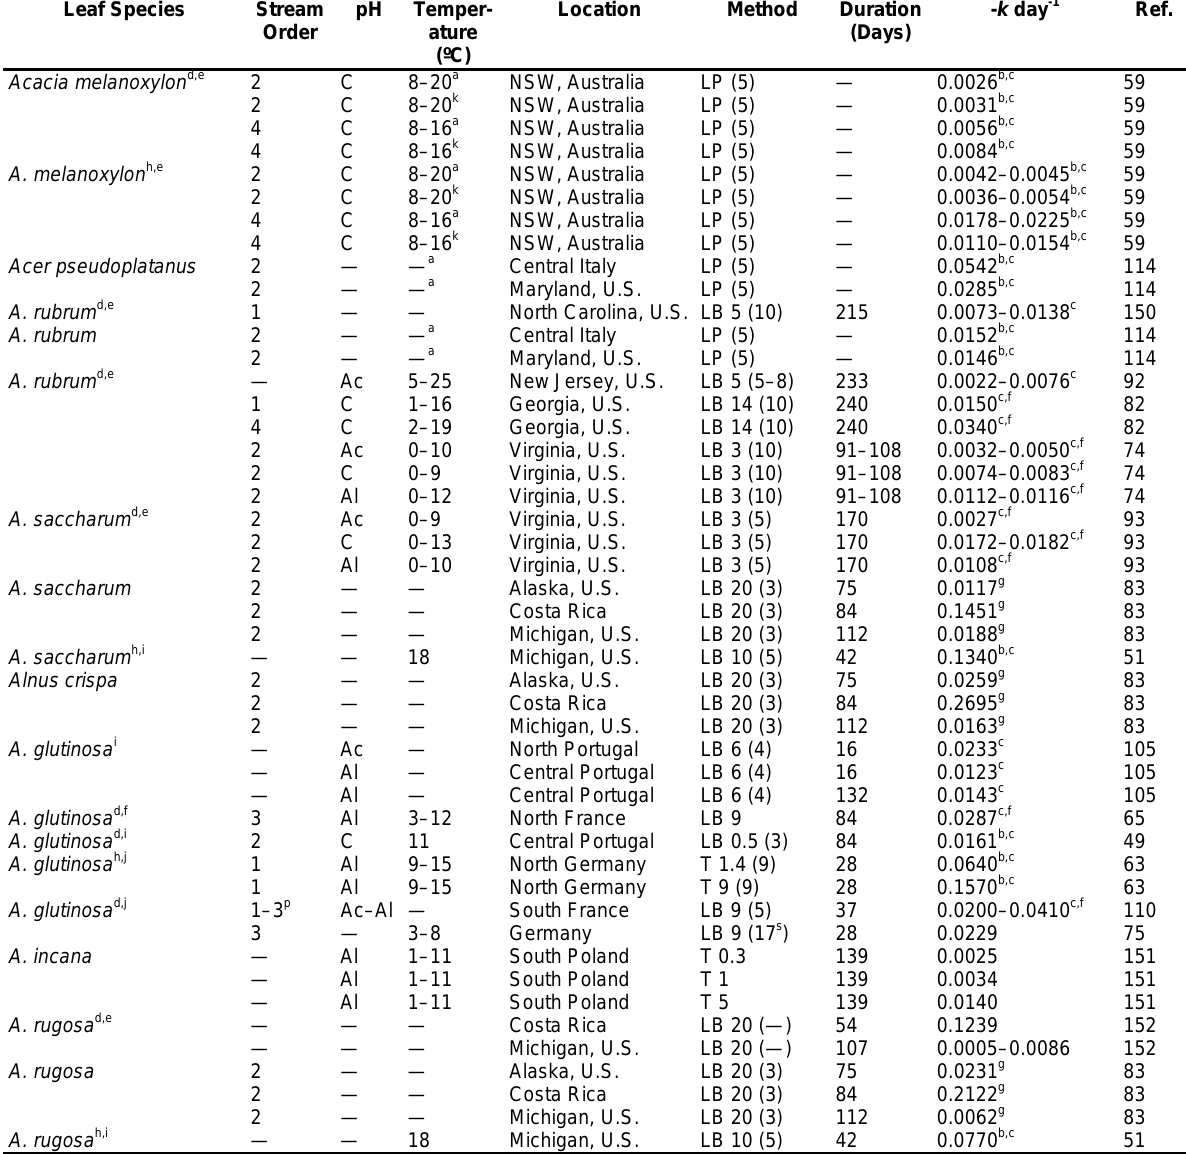
Breakdown Rates of Leaf Species in Streams of Differing